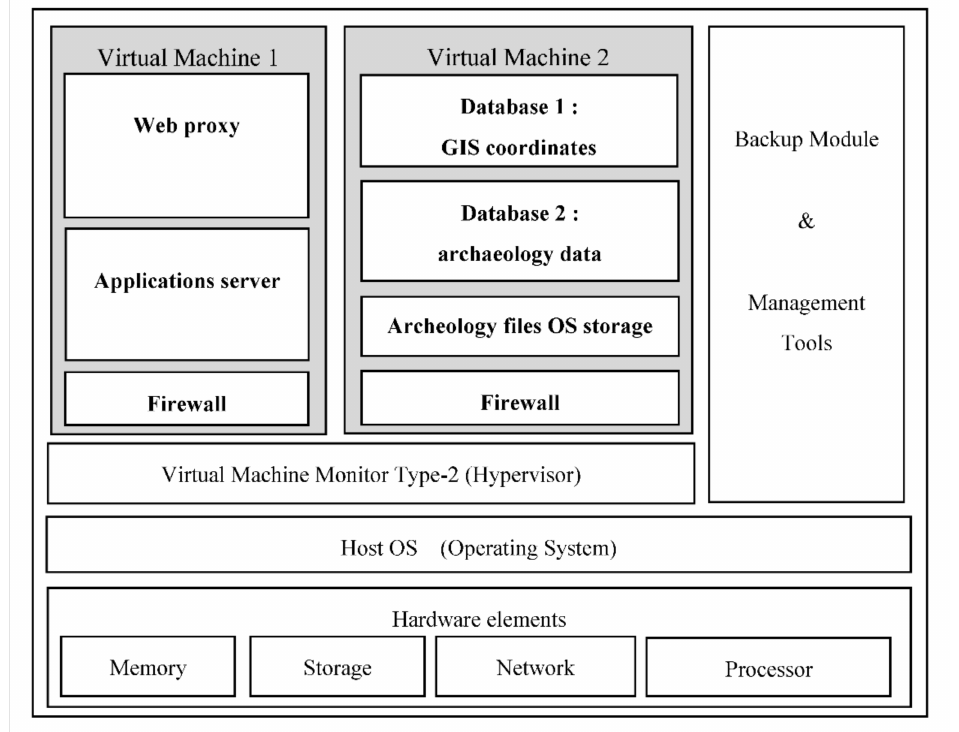
Figure 10. System’s hardware architecture based on a fully redundant